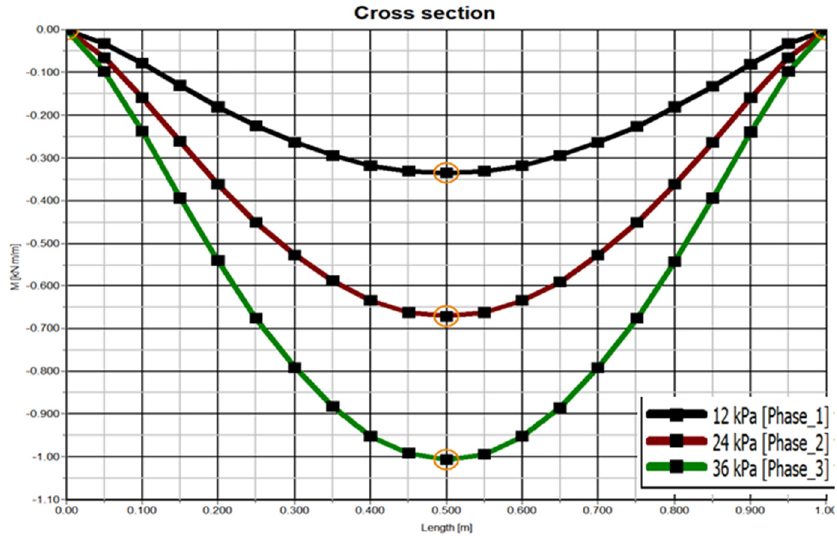
Figure 4. Bending moment of the footing.